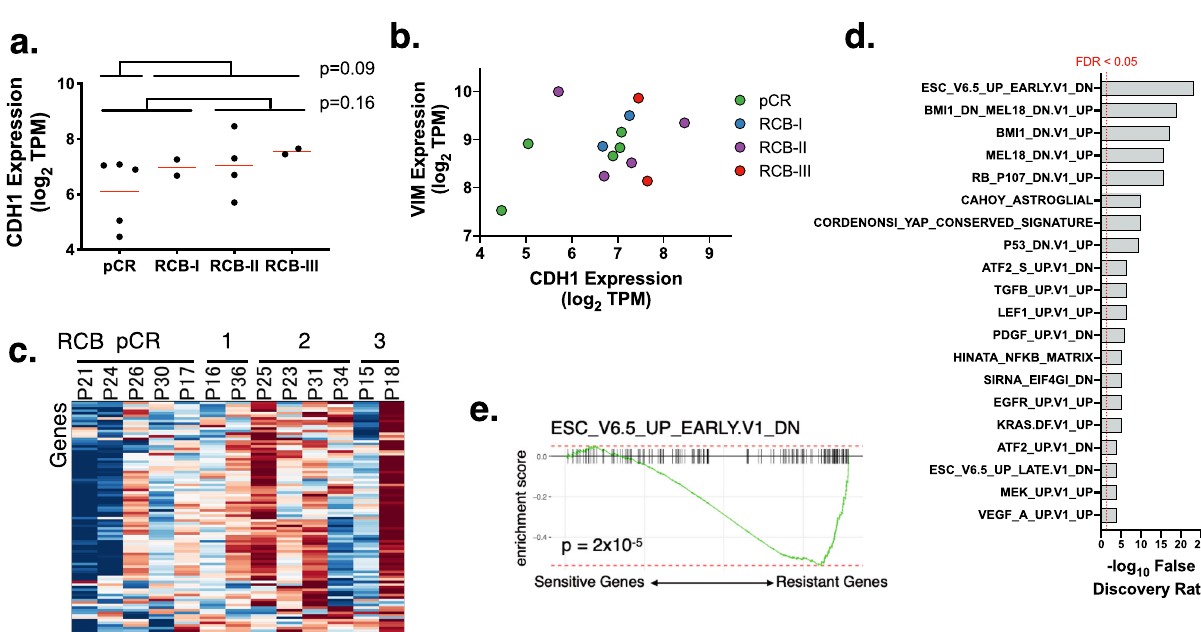
Fig. 4 A stem cell transcriptional program was associated with response. a The gene expression (log 2 TPM) of CDH1 is shown on the y -axis. Each dot is a tumor, grouped according to the response to talazoparib. The red lines indicate mean expression. The p -values (by unpaired two- sided Student ’ s t test) are shown for comparisons between patients with pCR vs other patients, as well as a comparison between pCR and RCB-I, and RCB-II and RCB-III. b The gene expression for CDH1 ( x -axis; log 2 TPM) and VIM ( y -axis; log 2 TPM) are shown for tumors colored by response. c The rows in the heatmap contain the genes in the leading edge of the EMT gene expression signature, and the columns are samples organized according to response. Warm colors indicate high expression of the genes. d The bars in this plot show the signi fi cance (as -log 10 of the false discovery rate) of the top 20 most signi fi cant oncogenic pathway (rows). The dotted red line shows the cutoff for a 5% false discovery rate. e The enrichment plots for the oncogenic pathway that is most signi fi cantly associated with response.